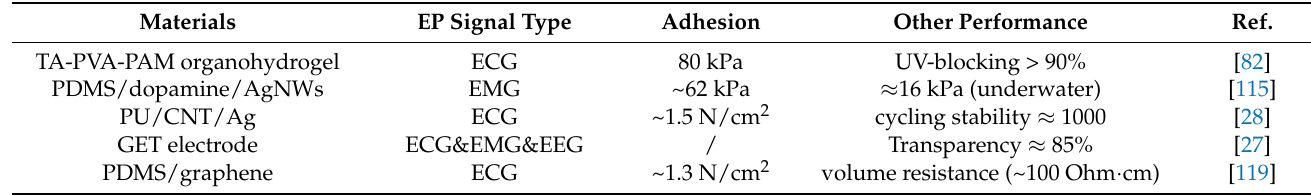
Table 2. Performance comparison of adhesive EP